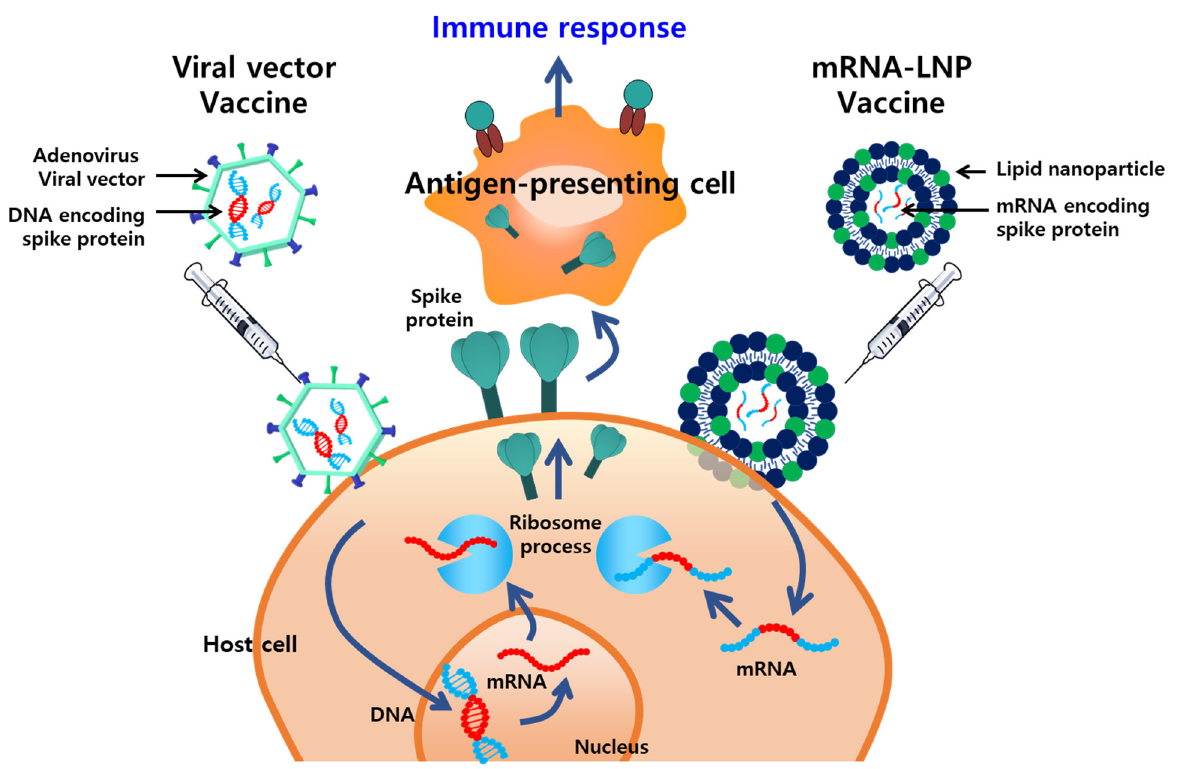
Figure 2. Overview of nanoplatform-based vaccines approved by the World Health Organization (WHO) for the prevention of emerging infectious diseases. Viral vectors and lipid NPs (LNPs) elicit potent immune responses by stably delivering DNA and mRNA encoding antigens, respectively, to antigen-presenting cells.